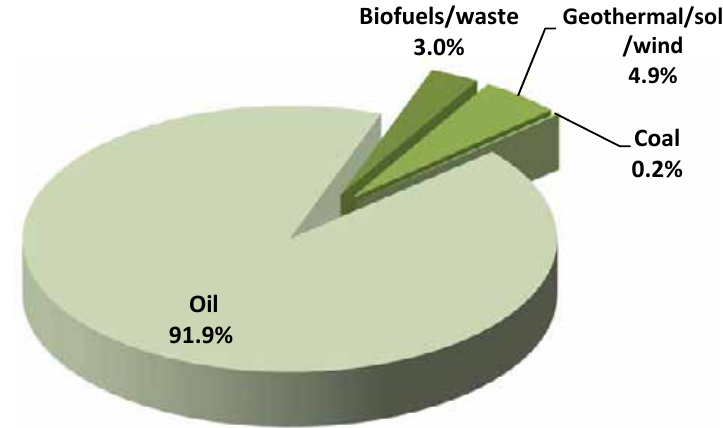
Fig. 1: Share of total primary energy supply in 2015 for Cyprus (IEA, 2015)